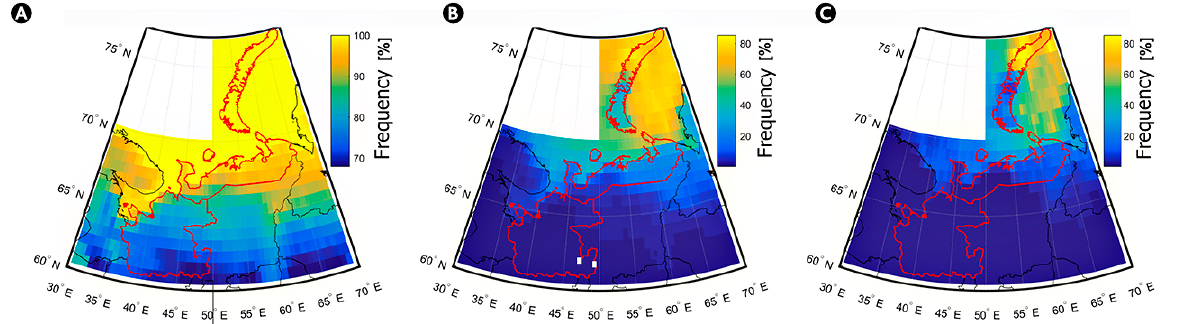
Figure 4. Spatial distribution of cold stress occurrence according to UTCI for the winter period (December-February) with gradations: strong cold stress (A) , very strong cold stress (B) and extreme cold stress (C)